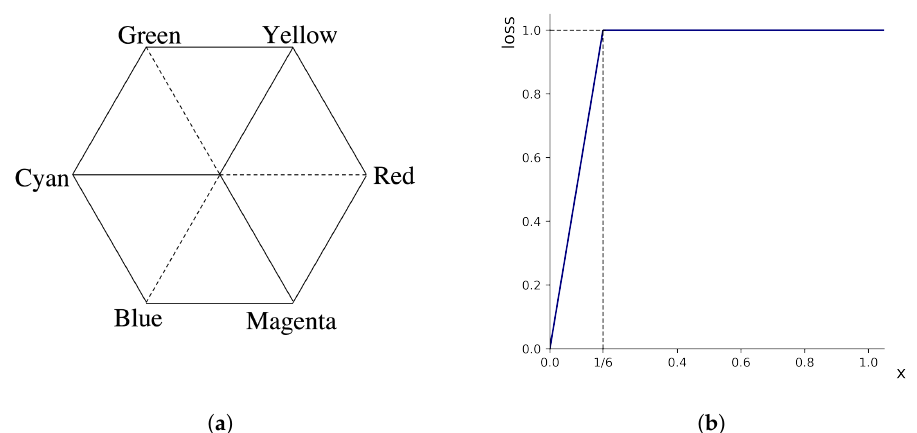
Figure 5. ( a ) Hue plane in a hexagonal model. ( b ) Loss function for the H channel ( L h ) where x = d h ( H 1 , H 2 )